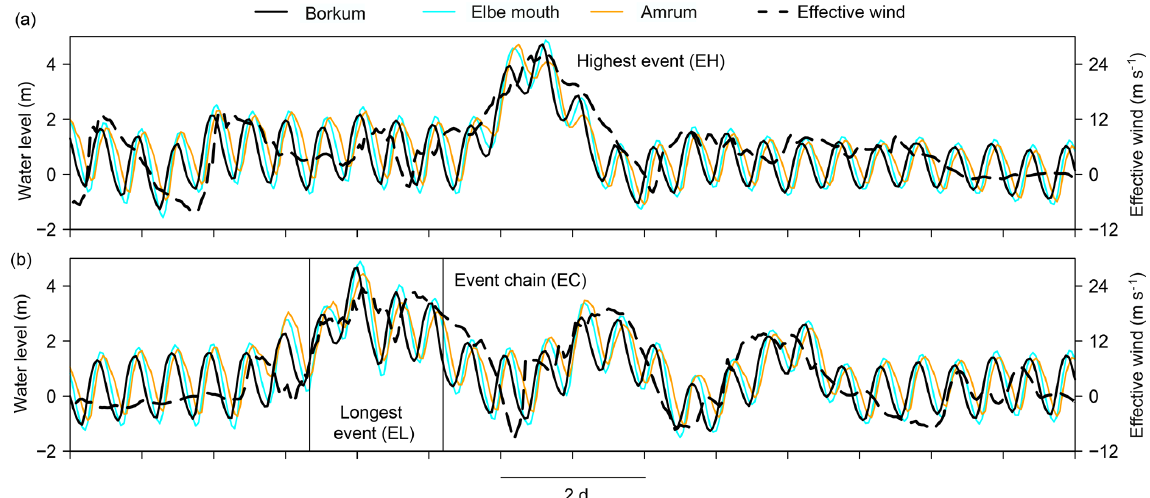
Figure 4. Time series of simulated water levels for three locations along the German Bight coast together with effective wind velocities for Borkum (dashed black line) for the highest event (EH; a ) and the event chain (EC; b ) over 14d. The first event in the event chain represents the longest event (EL).